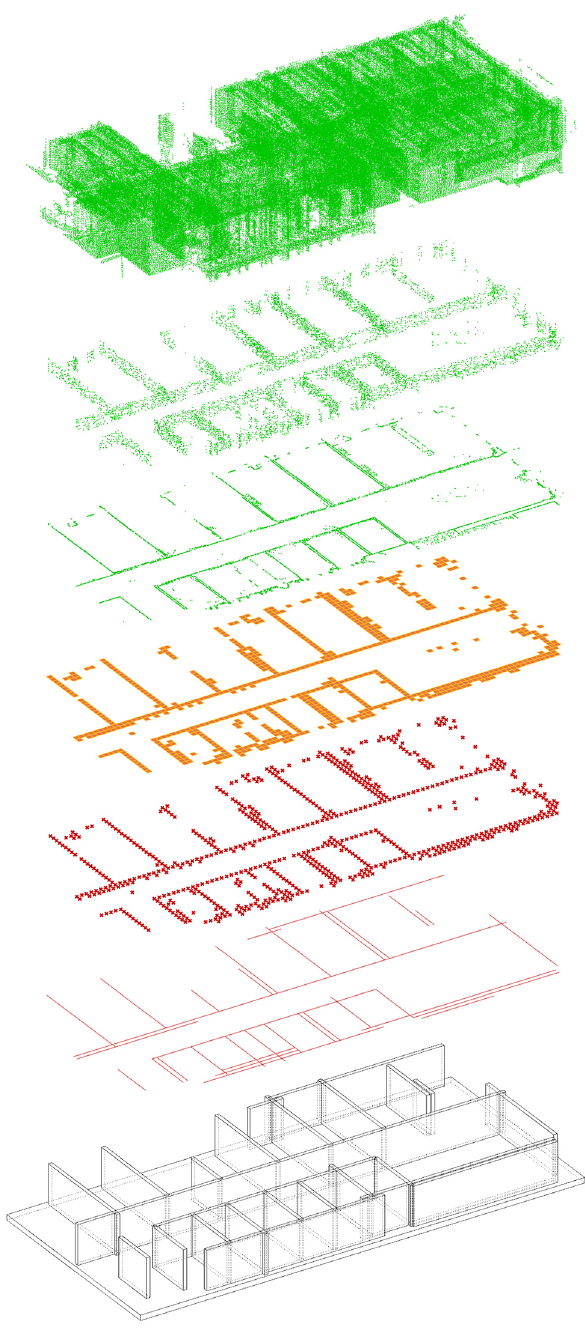
Figure 3 . Illustration of the main steps that the algorithm performs to arrive at the recognition and modelling of walls from the point